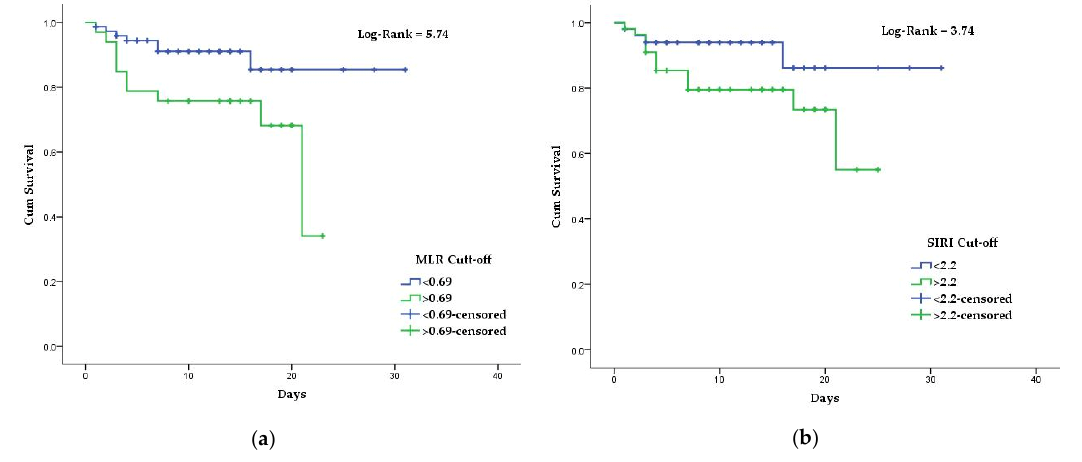
Figure 2. Kaplan–Meier survival curves of hospitalized COVID-19 patients: ( a ) according to estab- lished NLR cutoff values; ( b ) according to established dNLR cutoff values.